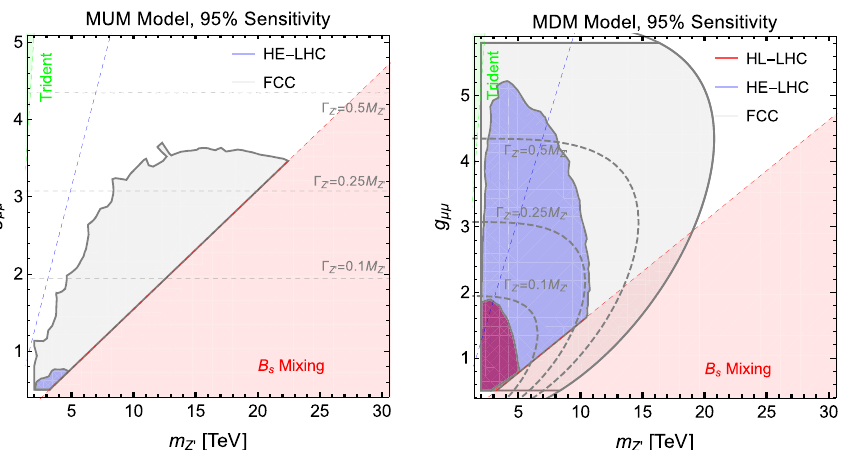
Fig. 14.3 95%CLsensitivitytoMUM(left)andMDM(right)Z (cid:3) mod- els in the anomaly-compatible parameter space varying g μμ and M Z (cid:3) . The grey shaded regions are the reach of the FCC-hh. The dashed grey contours give the Z (cid:3) width as a fraction of its mass. The red and green